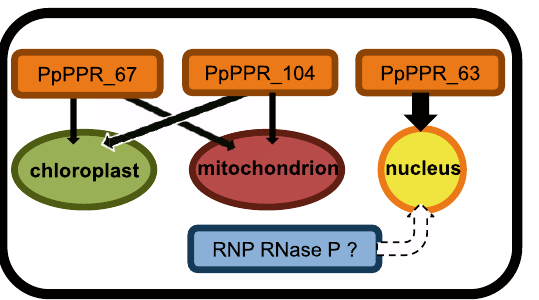
Figure 7. Schematic summarizing the localization of three PRORP homologs, PpPPR_63, 67, and 104 in P. patens. This study suggested that unidentified RNase P enzyme(s) including RNP-type RNase P may be present at least in the